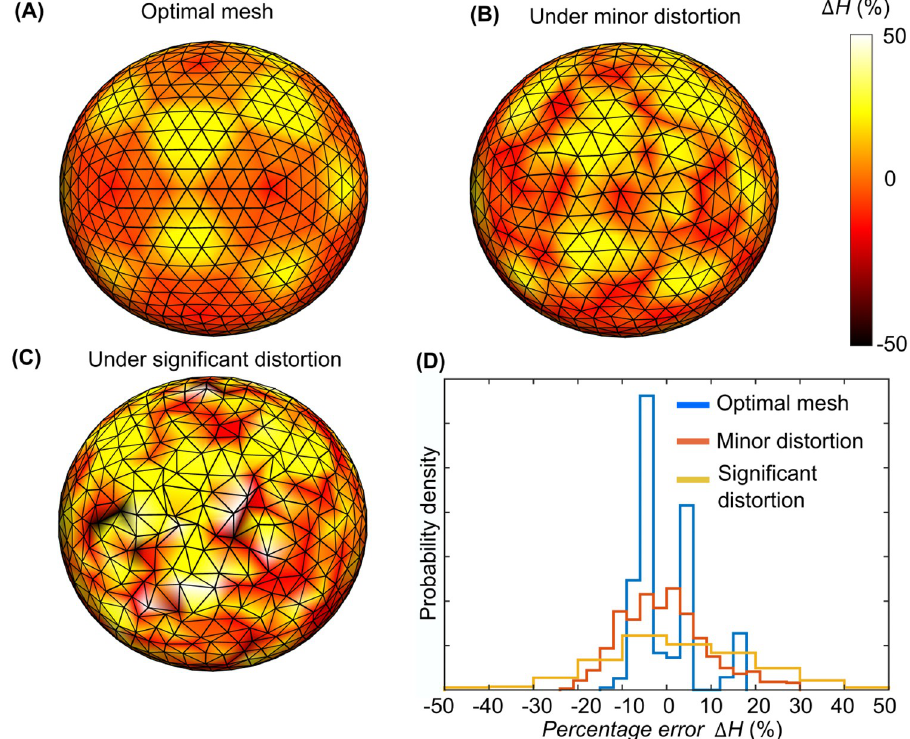
Fig 1. Error in Helfrich energy computation on meshes with variable quality. (A) Percentage difference Δ H between mesh calculated Helfrich energy and theoretical Helfrich energy on a sphere with optimal mesh quality (mesh generated by using [57]). (B) Δ H under minor distortion to the mesh. (C) Δ H under significant distortion. (D) Histogram of Δ H for (A-C). Percentage error Δ H = [ H ( i ) − H ( i )]/ H ( i ) × 100% comparing the computed, discrete value of the Helfrich energy H ( i ) at each vertex i (see Methods) to the exact value H ( i ) = 8 π κ / N Helfrich energy of an ideal sphere and N v is the number of